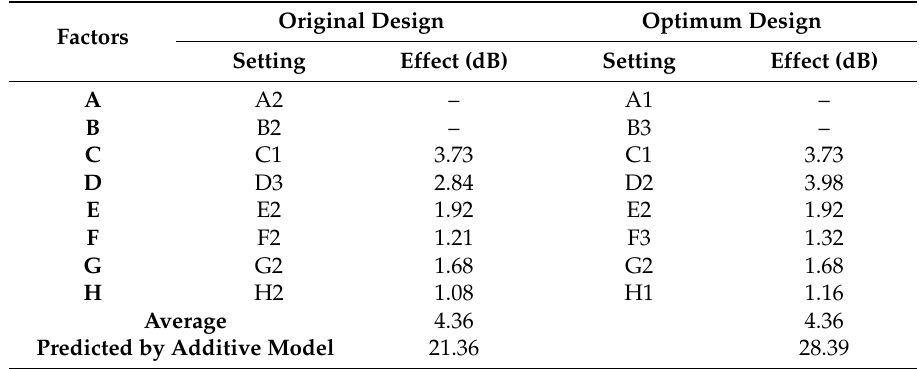
Table 7. SN ratios of the original parameter combination and the optimum parameter